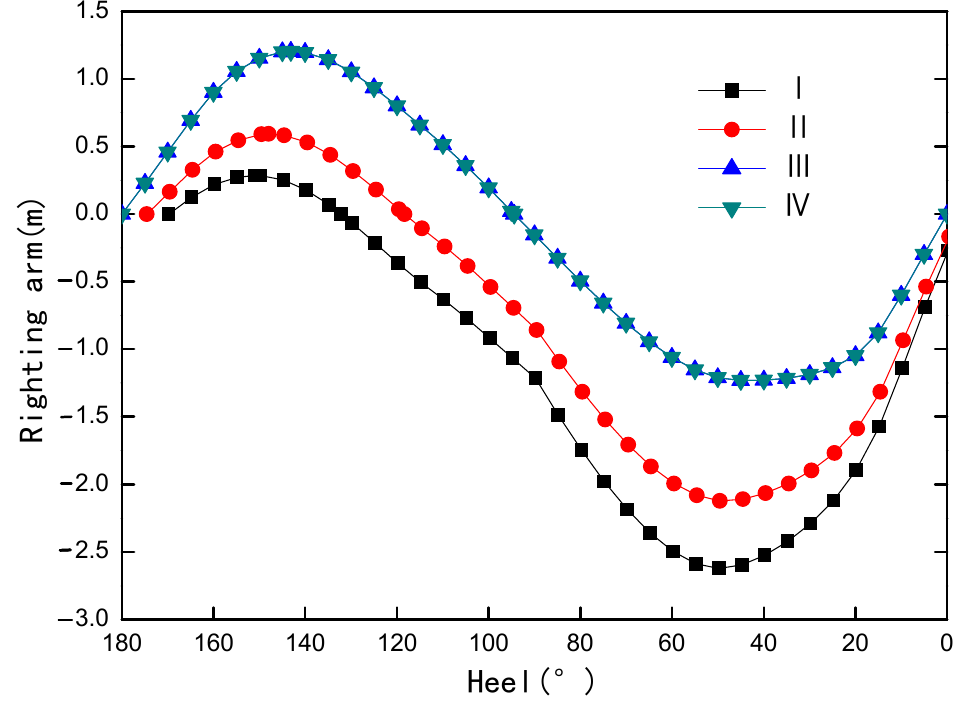
Figure 2. The static stability curves of a capsized ship.